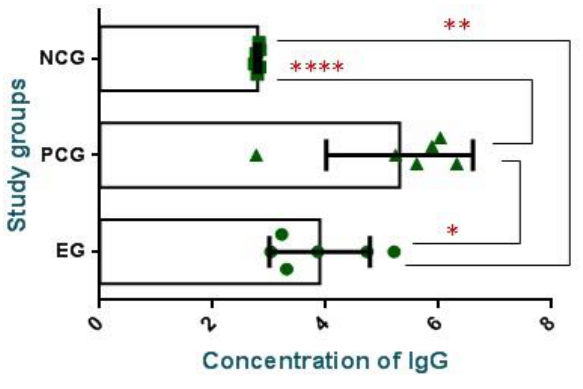
Figure 1. Figure (1): Total values of IgG among the study groups and the time points. (*), (**), and (****) referred to significant differences between groups as P≤0.05, P≤0.01 and P<0.0001 respectively.